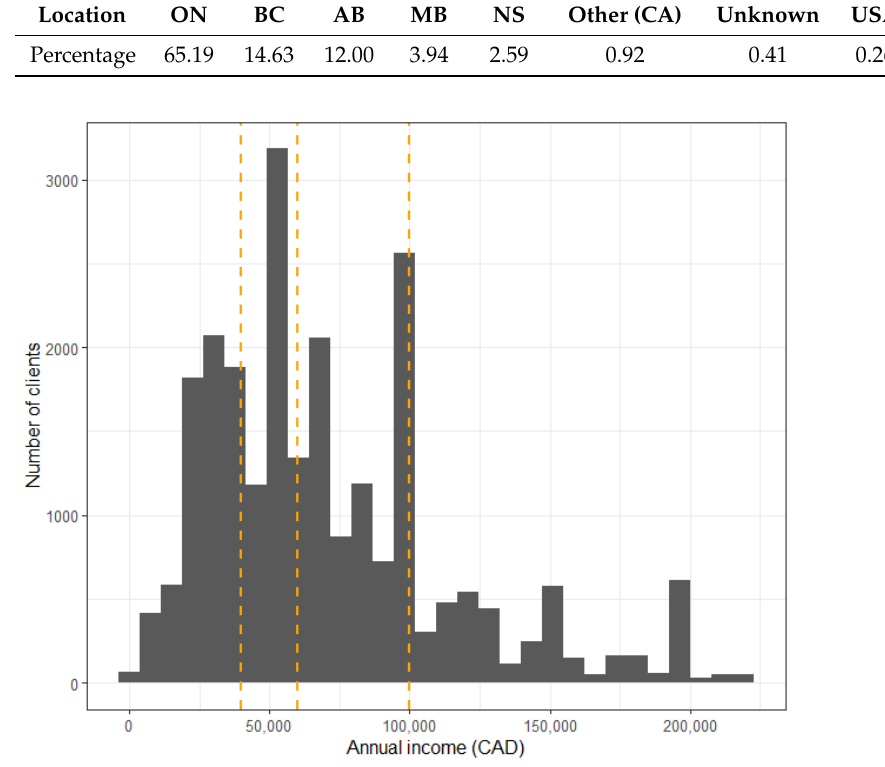
Figure 3. Distribution of client annual incomes. The vertical dotted lines represent the three quartiles at $40 k, $60 k, and $100